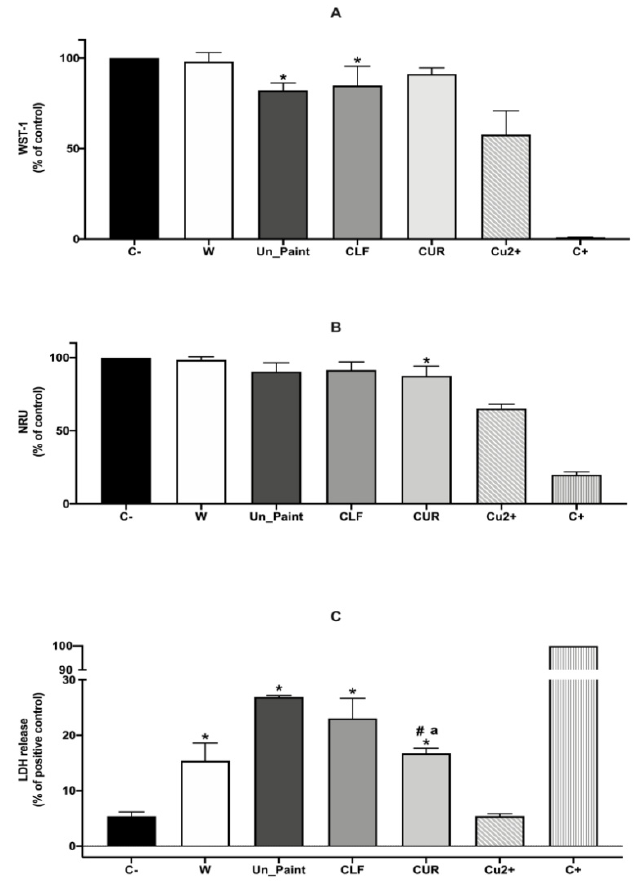
Figure 3. Results of WST-1 ( A ), NRU ( B ), and LDH ( C ) assays, with HaCaT cells, after 24 h of direct contact with CLF or CUR samples. C-: negative control, C+: positive control. The values are expressed as mean ± standard deviation. The statistical significance of samples compared with C- is represented by *, the statistical differences compared with Un_Paint are represented by # , and the statistical differences compared with CLF are represented by a . (One-way ANOVA; p < 0.05.)